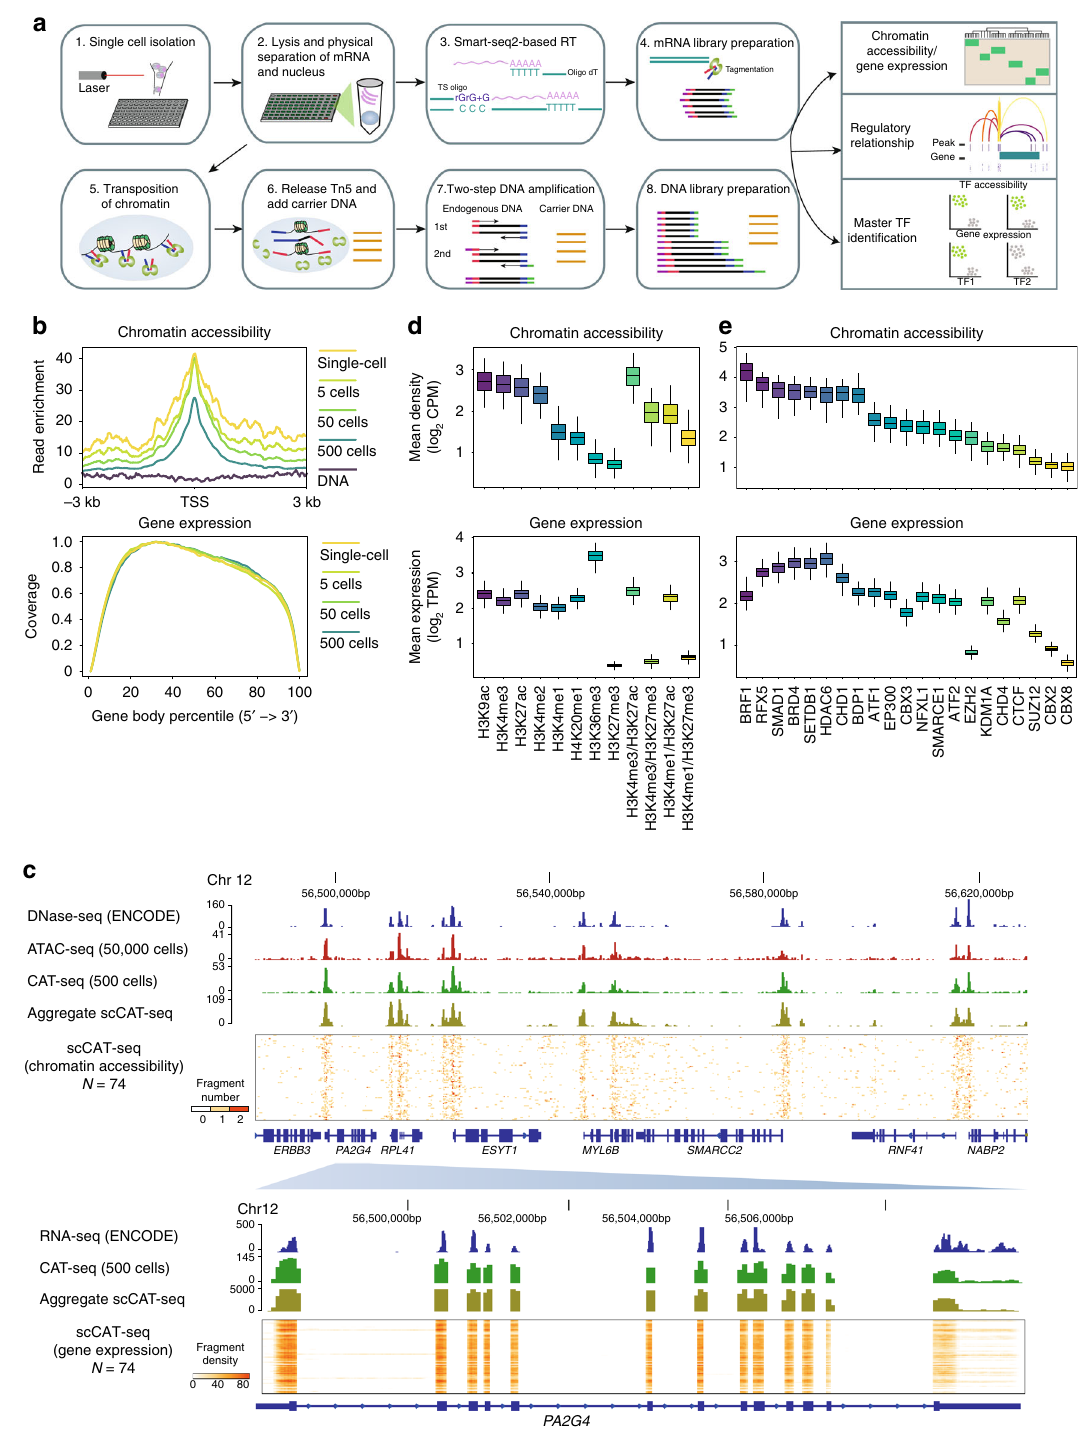
Fig. 1 scCAT-seq provides an accurate genome-wide measure of both chromatin accessibility and gene expression. a Overview of the scCAT-seq protocol. b Top panel: chromatin accessibility read enrichment around the transcription start site (TSS). Bottom panel: coverage of mRNA reads along the body of transcripts. Titration series (one single-cell, 5 cells, 50 cells, 500 cells) were marked by the indicated colors. All pro fi les were generated using the scCAT- seq protocol with the indicated number of cells as input. c A representative region showing a consistent pattern of chromatin accessibility and gene expression across datasets generated using different number of input cells. The bulk ATAC-seq track was generated using 50,000 K562 cells. The DNase- seq and bulk RNA-seq data of K562 cells were downloaded from ENCODE. The scCAT-seq tracks are chromatin accessibility (upper) and gene expression read density (bottom) from a total of 74 K562 single cells. d Top panel: mean chromatin accessibility read density around regions that are enriched by the indicated individual or combined histone modi fi cations. Bottom panel: mean expression level of genes associated with regions that are enriched by the indicated individual or combined histone modi fi cations. e Top panel: mean chromatin accessibility read density within regions that are bound by the indicated transcription factors. Bottom panel: mean expression level of genes associated with regions that are bound by the indicated transcription factors